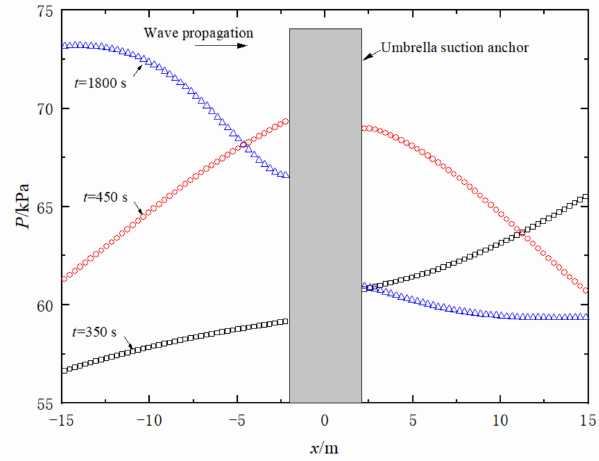
Figure 13. Pressure distribution around USAF.